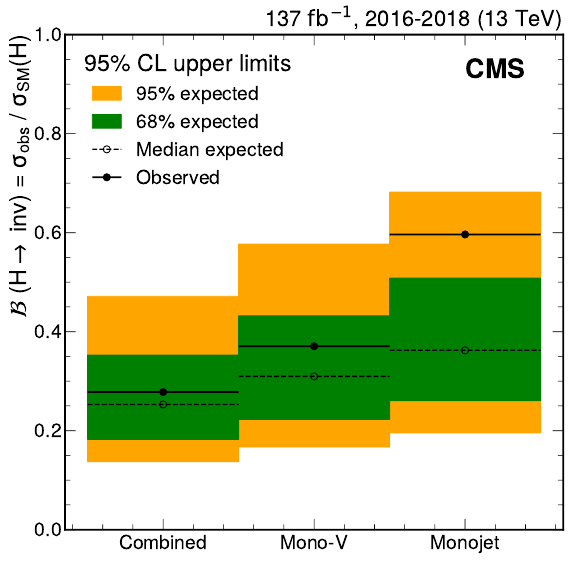
Figure 6 . Upper limits at 95% CL on the branching fraction B of the Higgs boson to invisible final states. The results are shown separately for the monojet and mono-V categories, as well as for their combination. The final combined limit is 27 . 8% ( 25 . 3%